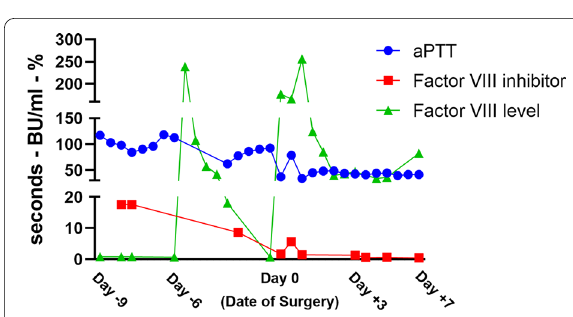
Fig. 2 Laboratory data demonstrating the therapeutic response of porcine recombinant Factor